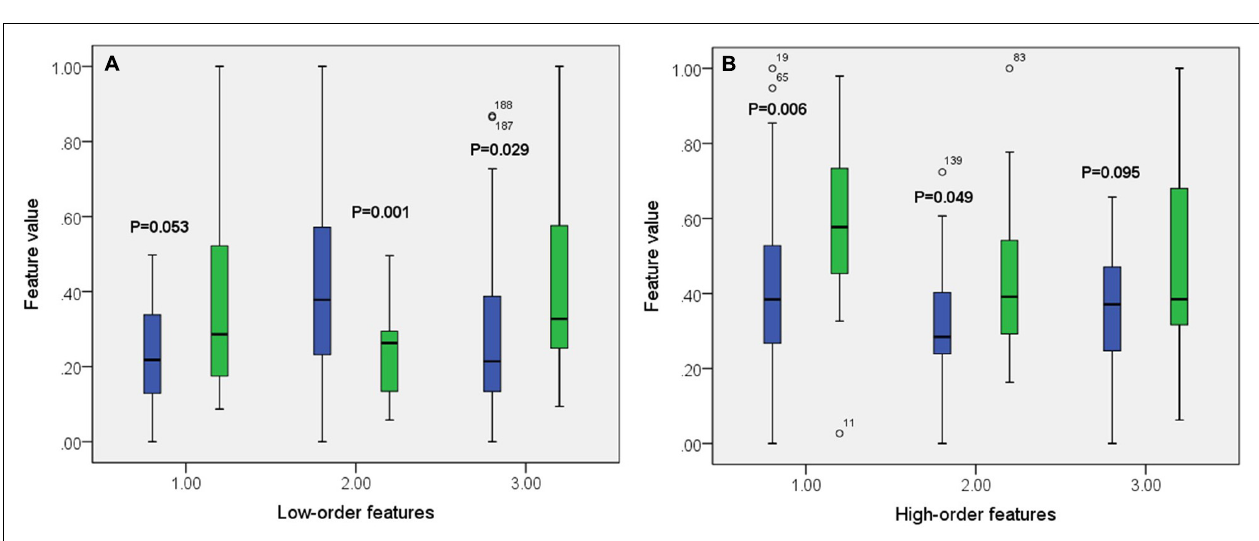
FIGURE 5 | Boxplot of some features from both low-order (A) and high-order (B) networks. The green color corresponds to DNR group while the blue color corresponds to no-DNR